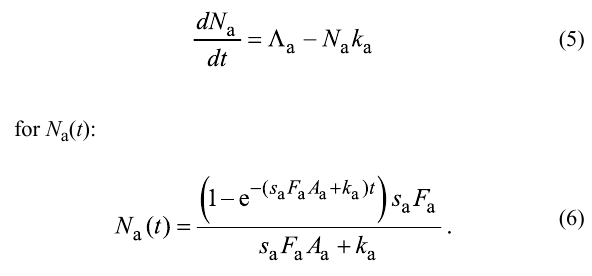
Figure 1: Steady state vertical growth rate of a deposit plotted as a function of electron flux. The linear region of the curve in the limit of low electron flux corresponds to the reaction rate limited growth regime.